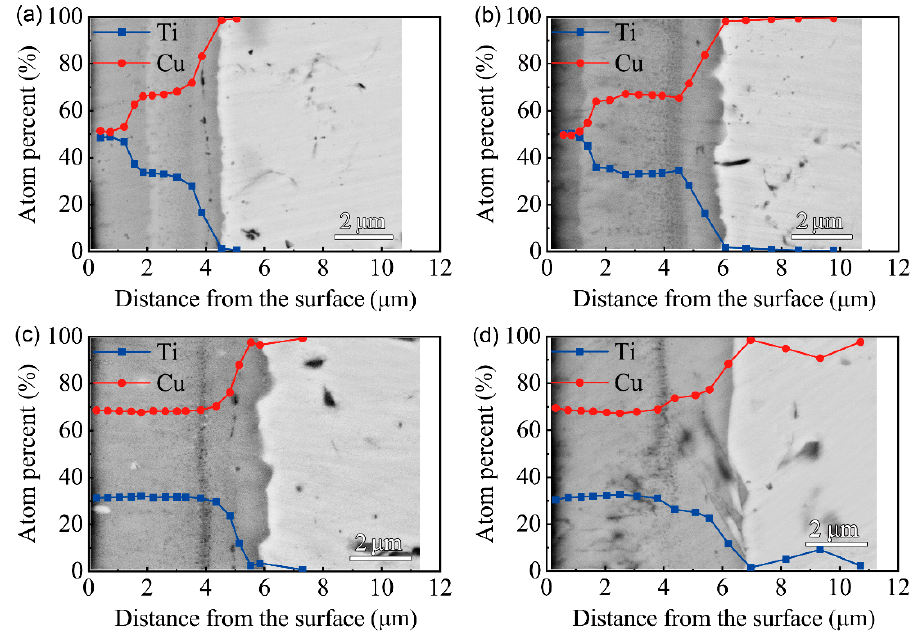
Figure 5. BSEM images of the cross-section and EDS results of F2 film on C17200 Cu alloy after thermal diffusion: ( a ) 650 °C for 1 h; ( b ) 650 °C for 4 h; ( c ) 750 °C for 1 h; ( d ) 750 °C for 4 h.